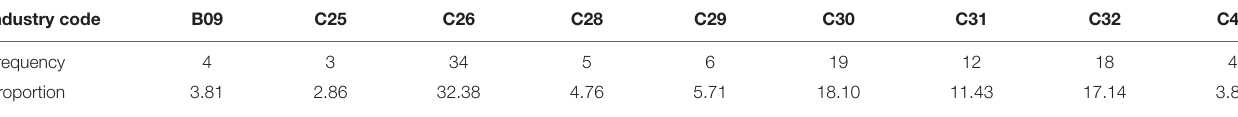
TABLE 2 | Sample industry distribution of experimental group.